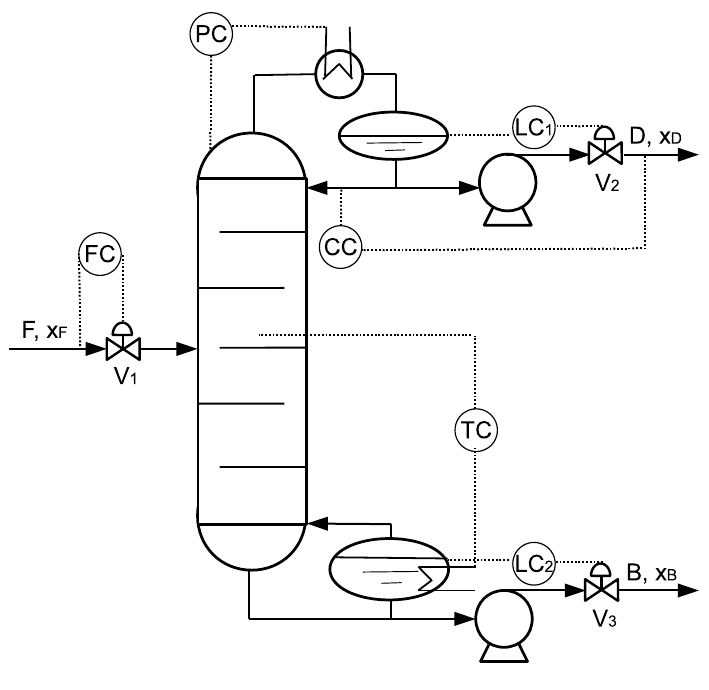
Figure 12. A schematic diagram of the control structure implemented in the distillation column. Flow rate controller FC , pressure controller PC , and both level controllers LC 1 and LC 2 have fixed set-points, and concentration controller CC and temperature controller TC receive set-points from the